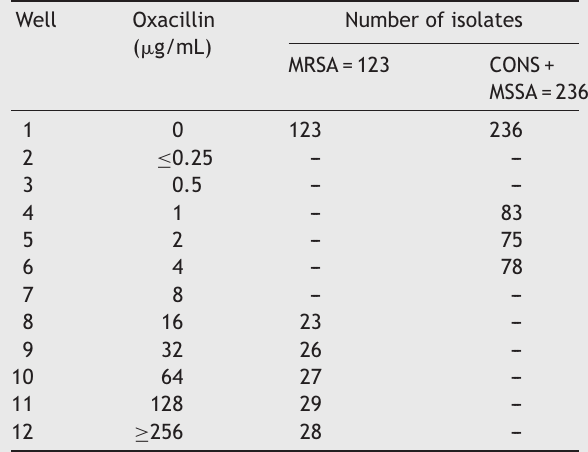
Detection of MRSA and ‘CONS + MSSA’